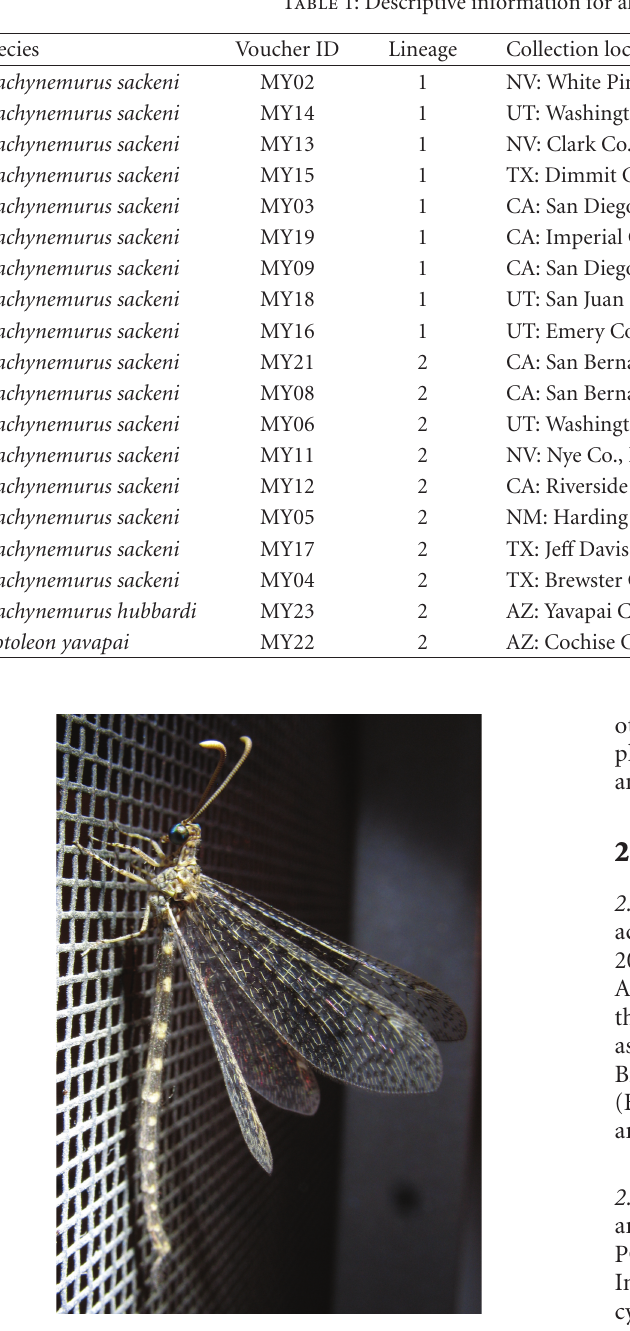
Figure 1: Male Brachynemurus sackeni from Deep Canyon, Califor-